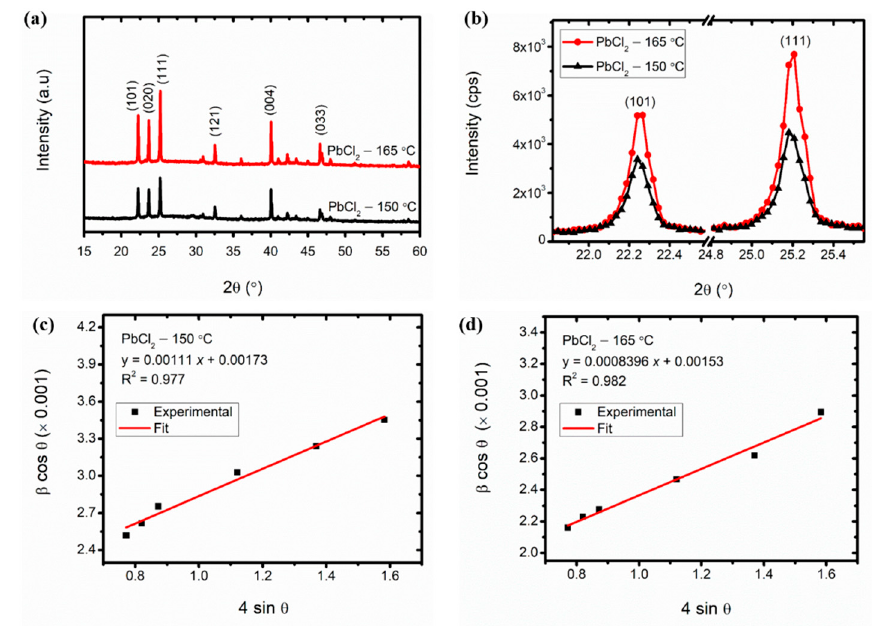
Figure 5. ( a ) Full XRD patterns of PbCl 2 thin films on glass, deposited at different substrate temperatures; ( b ) zoomed XRD patterns showing the two intense (101) and (111) peaks of the PbCl 2 films; ( c , d ) Williamson–Hall plots for crystallite size and strain estimation of the two PbCl 2 films.